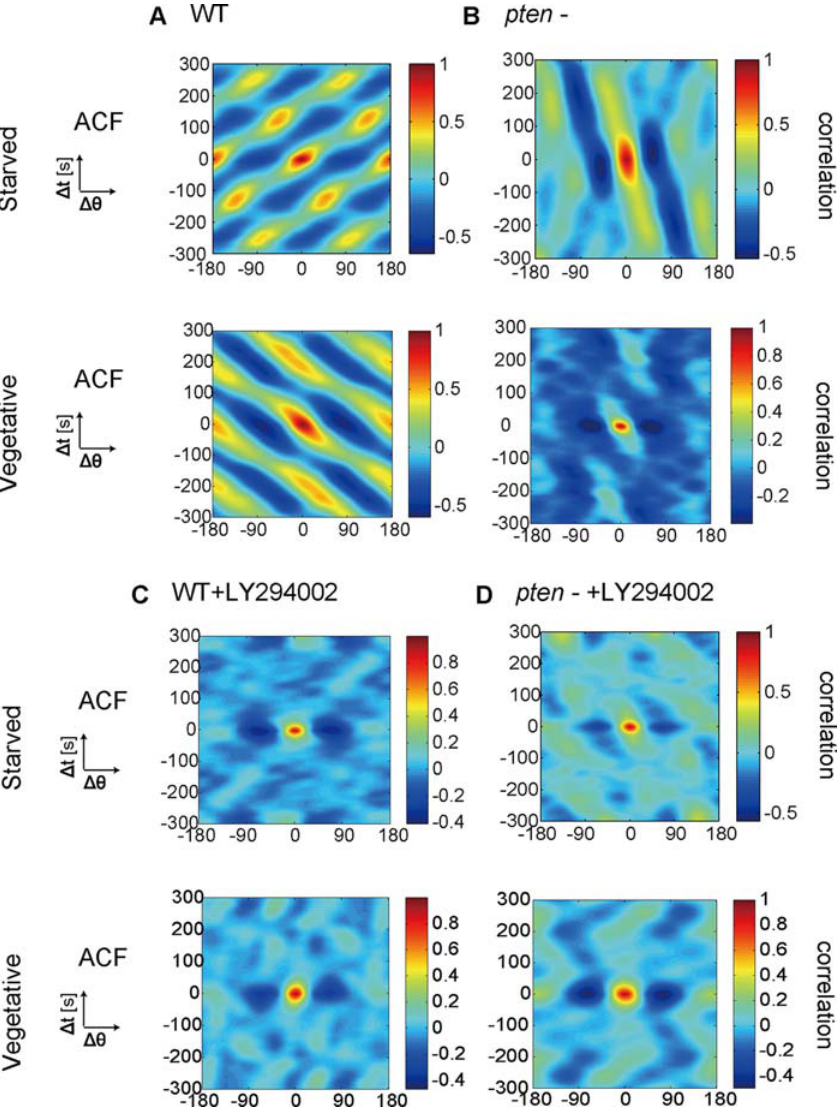
Figure 4. Ordered patterns of morphological dynamics are disorganized following knockdown of PTEN and following inhibition of PI3K. Typical ACFs of Amp ( h ,t ) are shown for (A) WT, (B) pten 2 , (C) WT + LY294002 and (D) pten 2 + LY294002. Upper: the STA state, Lower: the VEG state. LY294002 is a specific inhibitor of PI3K.